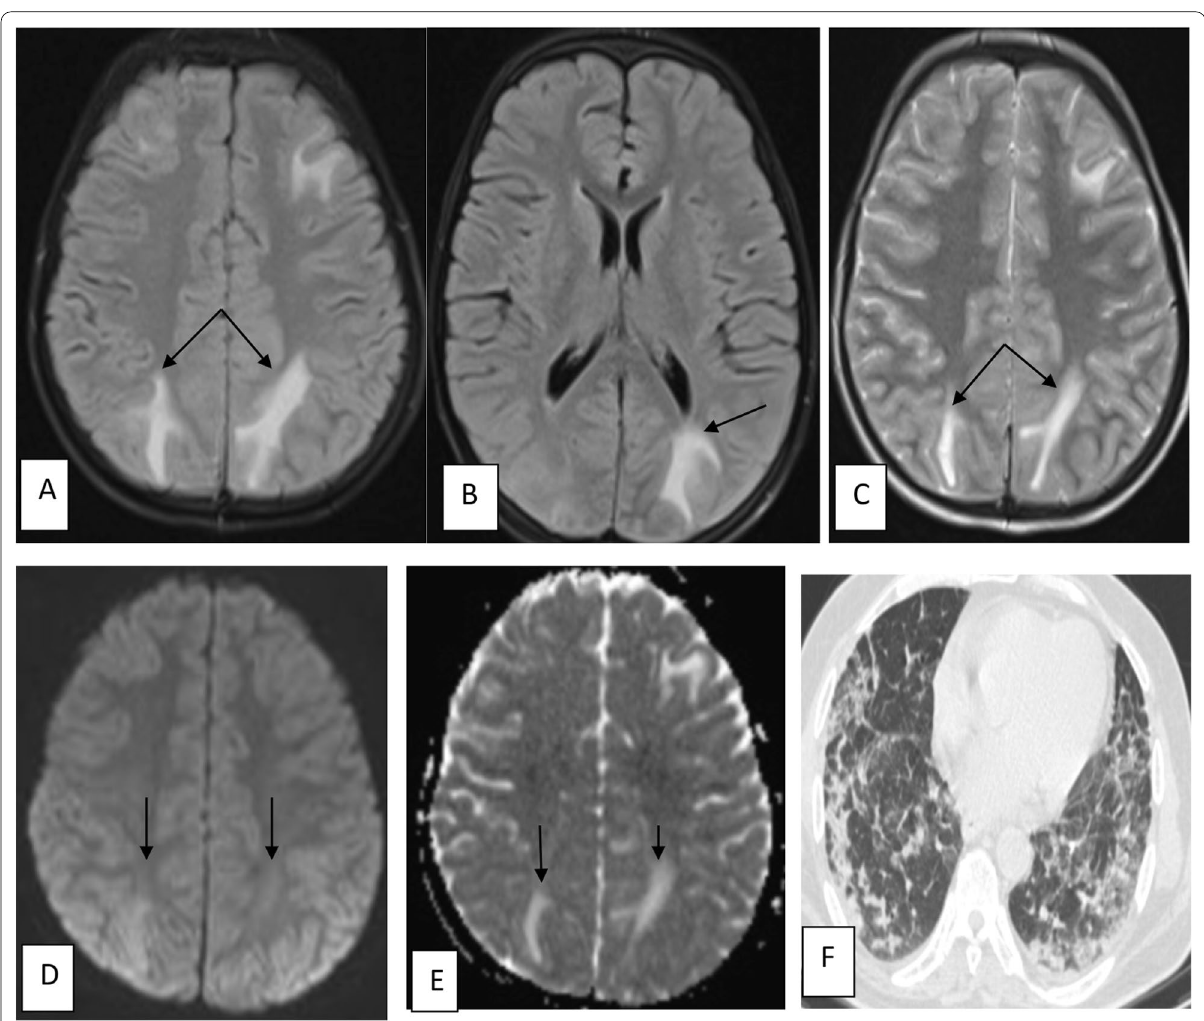
Fig. 10 Female patient aged 40 years old known to be hypertensive with recent history of COVID‑19 developed altered consciousness. MRI brain shows multiple nearly symmetrical subcortical patchy areas of altered signal intensity are seen at both high parietal and, occipital regions (black arrows) displaying high signal in FLAIR and T2 WI ( A – C ), free diffusion in DWI & ADC ( D , E ) this MRI features are suggestive of PRES